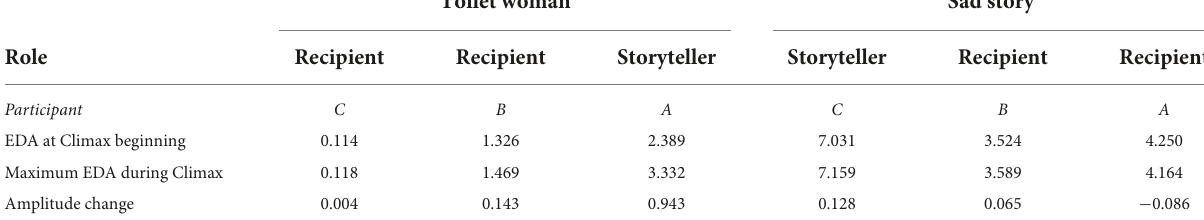
TABLE 1 Electrodermal activity (EDA) during Climax by participants and stories. Toilet woman Sad story Recipient